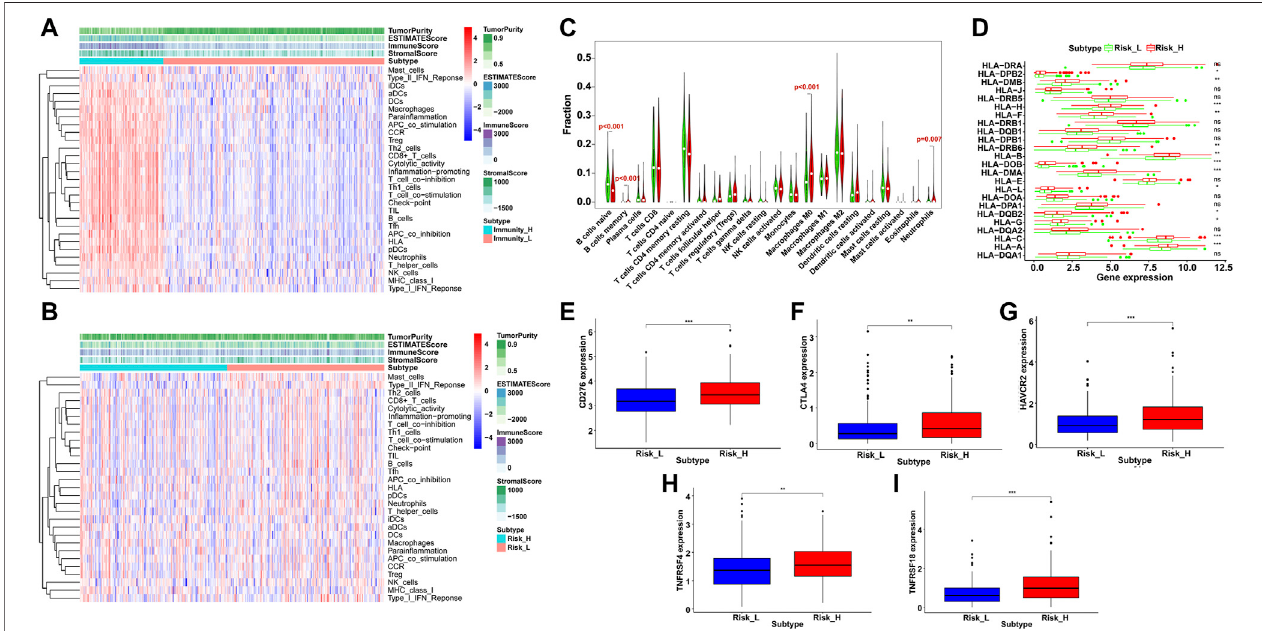
FIGURE 9 | Immune in fi ltration and pro fi le analysis in HCC. By ssGSEA, immunocyte subtypes and pathways enrichment (A) in high- and low-immunity clusters and (B) in high- and low-risk groups. The immune score, stromal score, ESTIMATE score and tumor purity were shown in the heatmaps. (C) Violin plots of in fi ltrated immunocyte subtypes between high-risk (red) and low-risk (green) groups. (D) Differential expression level of HLA related genes between high-risk (red) and low-risk (green)groups(ns (cid:1) notsigni fi cant,*p < 0.05,**p < 0.01,***p < 0.001).Theexpressionlevelofimmunecheckpointgenesbetweenhigh-risk(red)andlow-risk(blue) groups, including CD276 (E), CTLA4 (F), HAVCR2 (G), TNFRSF4 (H) and TNFRSF18. ( I ) **p < 0.01, ***p <